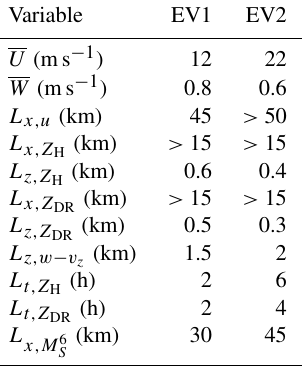
Table 1. Summary of the characteristic scales for the two events (see Figs. S1 and S2 for details). L d,X refers to the scale of variation in the variable X in the direction d , and M 6 is the sixth moment of the S snow particle size distribution from the WRF simulation, a proxy for Z H .